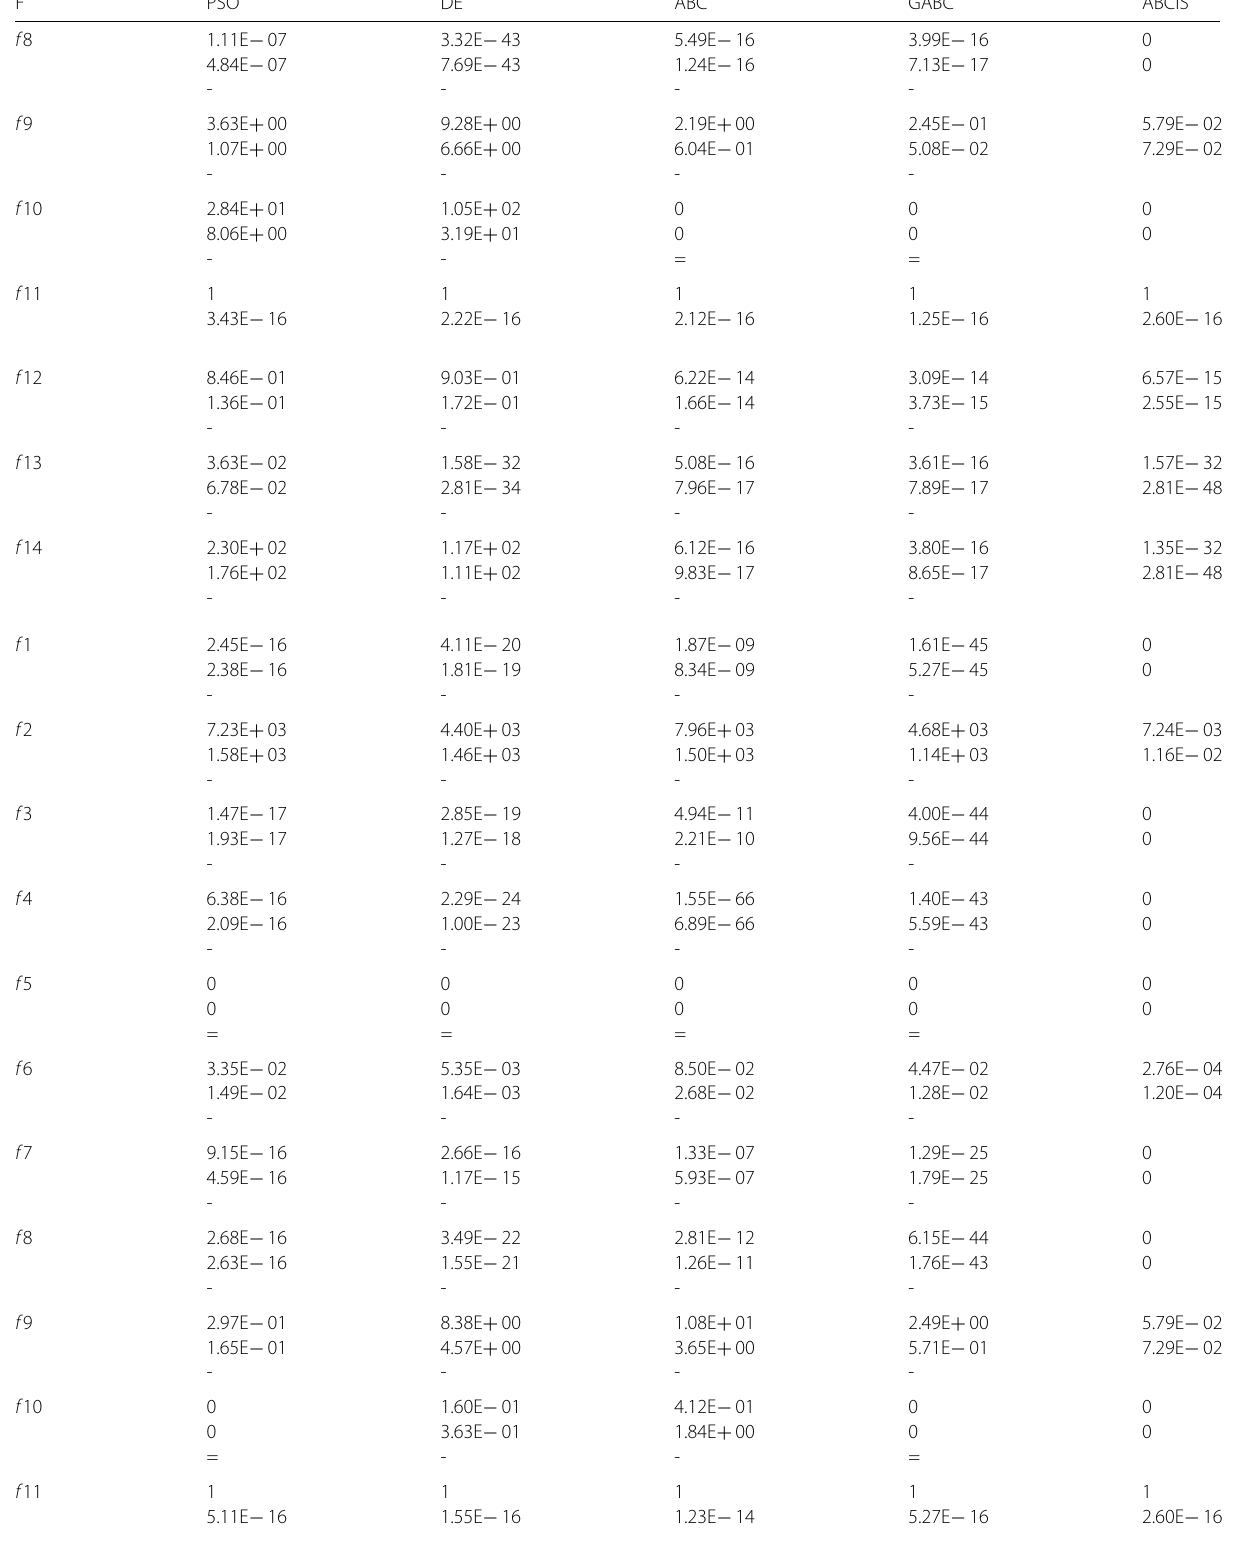
Table 3 Comparison results, D = 30 ( Continued